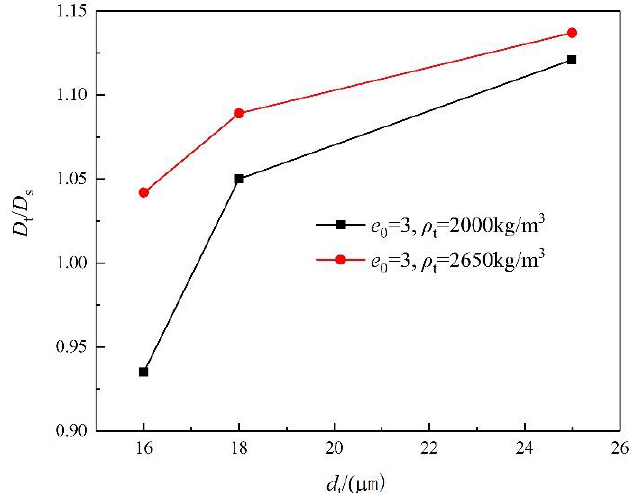
Figure 10. Variations of stable values of the displacement ratio D t /D s with respect to the tracer diameter dt for two mass densities of the tracer, ρ t = 2000 kg/m 3 and 2650 kg/m 3 . For slurries of different particle concentrations, the variations of D t / D s with t were compared in Figure 11a for two initial void ratios, i.e., e 0 = 2 and 3. In producing Figure 11a, the diameter and mass density of the tracer were, respectively, taken as d t = 18μm and ρ t = 2650 kg/m 3 , i.e., Cases 2 and 4. By changing ρ t = 2650 kg/m 3 to 2000 kg/m 3 , the Cases 2 and 4 become Cases 6 and 8, for which the corresponding results are presented in Figure 11b. For both considerations on the mass densities, it was seen that the stable values of D t / D s increased with e 0 , which means the representativeness of the tracer be- came worse for slurries of higher initial void ratio. Comparing Figures 11a and 11b, it can also be found that the representativeness of the tracer increased when the density of the tracer decreased. For all of the eight cases considered in Table 4, Case 8 gives the best representativeness on the displacements of the slurry particles that were driven by the vacuum gradient. ( a ) ( b ) Figure 11. Variations of displacement ratio D t / D s between tracer and slurry particle with respect to time t under condi- tions of e 0 = 2, 3 and d t = 18 μm: ( a ) ρ t = 2650 kg/m 3 ; ( b ) ρ t = 2000 kg/m 3 . 6. Discussions From the eight cases in Table 4 that cover the common ranges of material parameters governing the PIV model tests on the dredged slurry, the stable displacement ratio 0 . 000 . 030 . 060 . 090 . 120 . 150 . 180 . 21 1 . 020 1 . 035 1 . 0 50 1 . 065 1 . 080 1 . 095 1 . 110 C a s e 2 , d t = 18 m , e = 3 ， t = 2650kg / m 3 C a s e 4 , d t = 18 m , e = 2 , t = 2650kg / m 3 D t / D s = 1 . 082 D t / D s = 1 . 089 D t / D s t / ( s ) 0 . 000 . 030 . 060 . 090 . 120 . 150 . 180 . 21 0 . 925 0 . 950 0 . 9 7 5 1 . 000 1 . 025 1 . 050 1 . 075